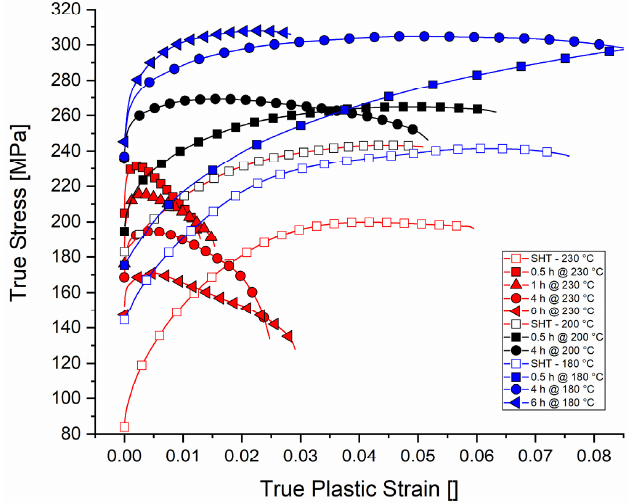
Table 2. List of experimental conditions for the relaxation tests.